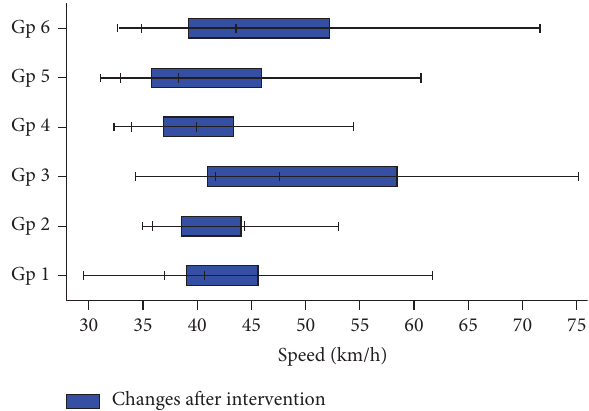
Figure 3: Changes in the mean speed in the 40km/h zone after the intervention (the error bars represent the standard variance).